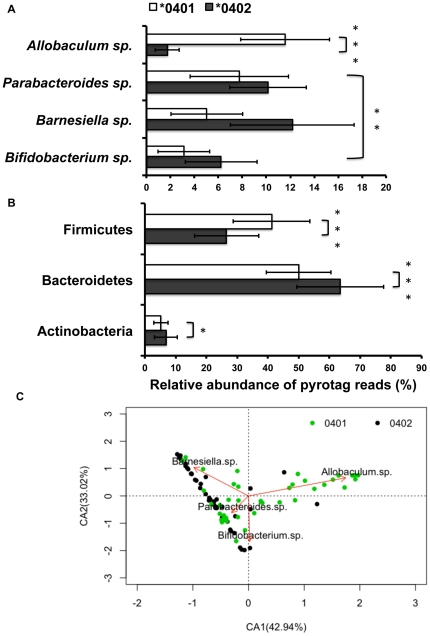
Relative abundance of OTUs in the fecal microbiomes of *0401 and *0402 mice.(a) Allobaculum sp. is is the most abundant OTU in the *0401 mice, while Barnesiella sp. occurs with highest frequency in *0402 mice (P<0.05). (b) Similar taxa distributions are observed at phyla level with Bacteroidetes: Firmicutes ratios more even in *0401 (n = 41) compared to *0402 (n = 45) mice. Data are presented as mean ± S.E., *P<0.05, **P<0.01, ***P<0.001. (c) Correspondence analysis plot shows the degree of correlation between specific OTUs and mice genotype. The red vectors point to the center of gravity of the samples where each OTU mostly occurs. The distance between the tip of the vector and the samples (dots) give an indication of the probability of OTU content in each sample. Green and black dots represent *0401 and *0402 fecal samples respectively. Percentages in parentheses in the CA plots describe the amount of variation explained by each axis.